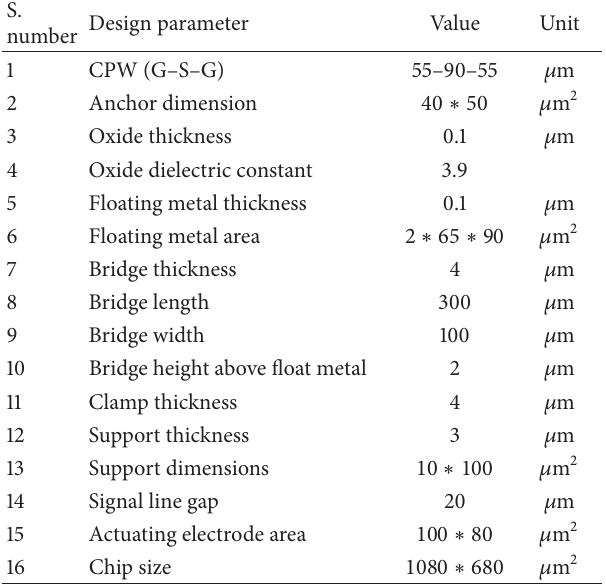
Table 1: Design parameters used in the proposed switch